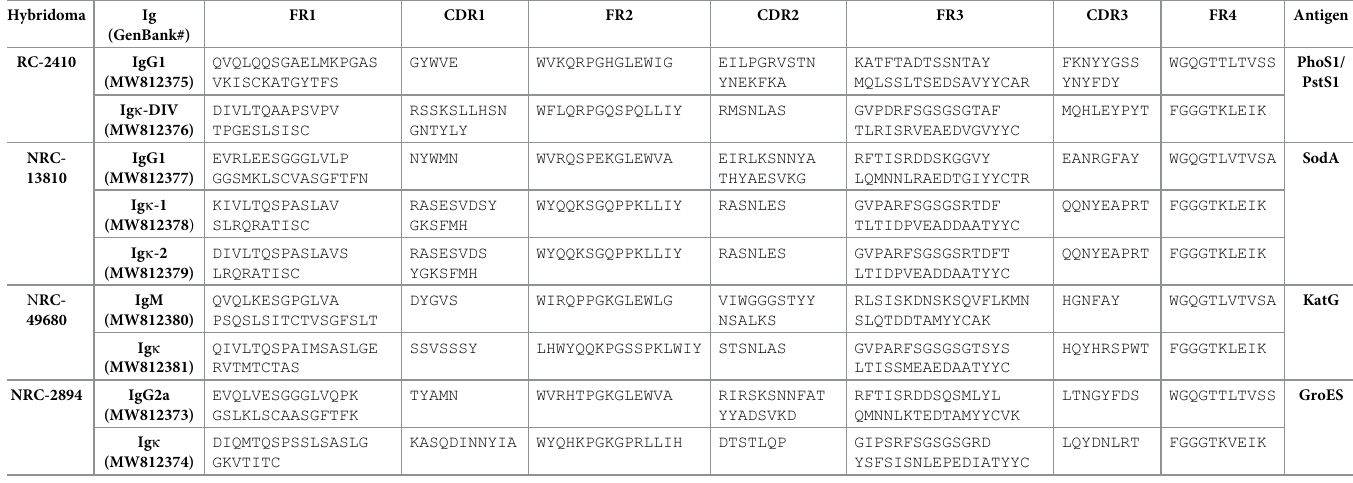
� S6 Table lists the CDR/FR gene family used for alignment.